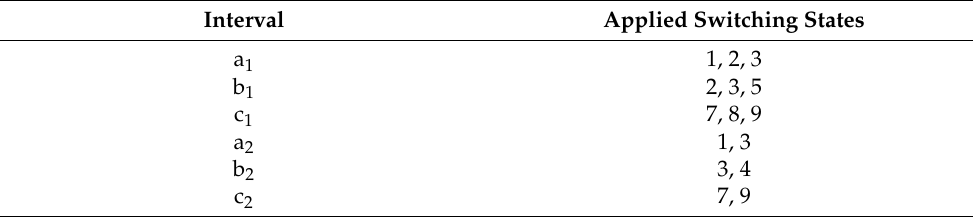
Table 7. Applied switching states corresponding to each interval in Figures